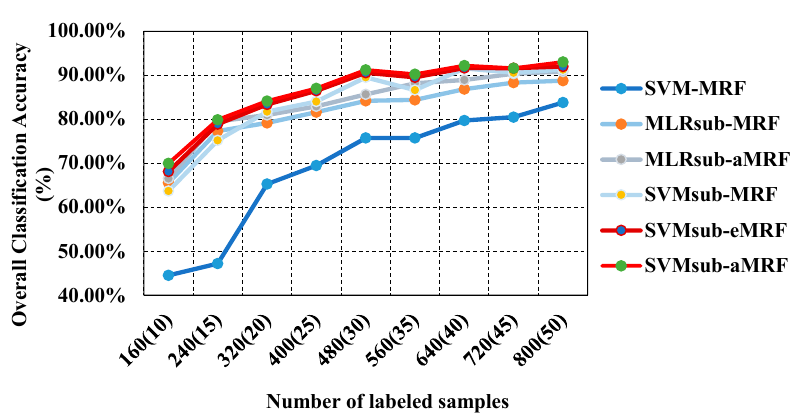
Figure 6. Overall accuracy results as a function of the number of labeled samples for the Indian Pines data set.